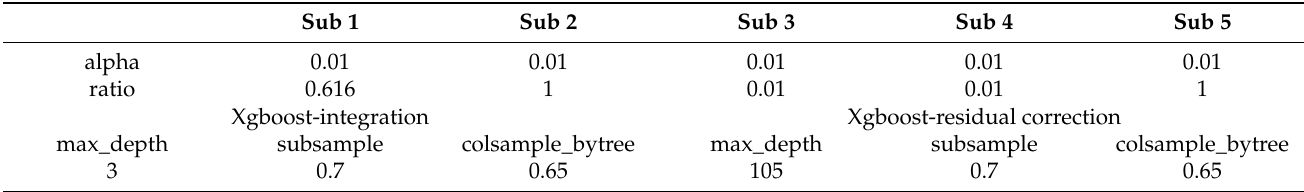
Figure 10. The first five subfigures are the point prediction results of subseries. The sixth subfigure titled “Xgboost integration” shows the integrated results. The seventh subfigure represents the final point prediction results which are generated based on the Xgboost integration and error correction strategy. The last subfigure is the residual comparison between the model with error correction strategy and the model without it. All the experimental results here used data in case 2. Table 4. Parameters used in case